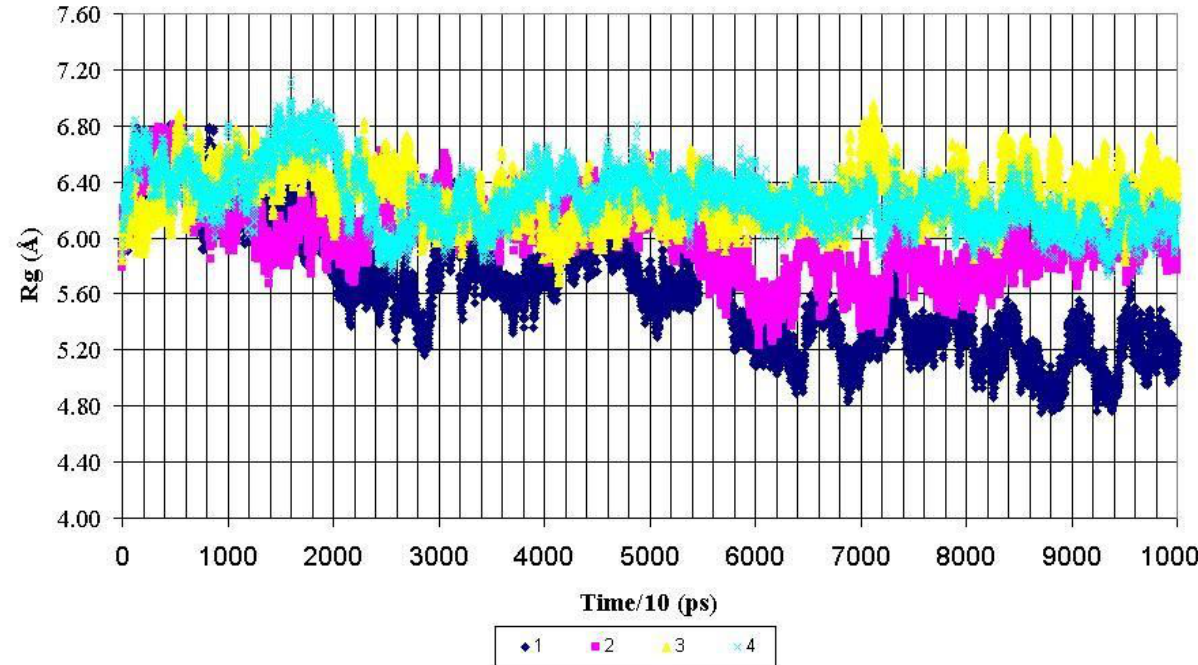
Figure 3. Radius of gyration (Rg) for backbone heavy atoms of the PDTRPAP fragment of the nonglycosylated peptide AHG21 – (1) and glycosylated peptides: AHG21 (T17) – (2), AHG21 (T5) – (3), AHG21 (T5, T17) – (4) during 1.0 ns MD